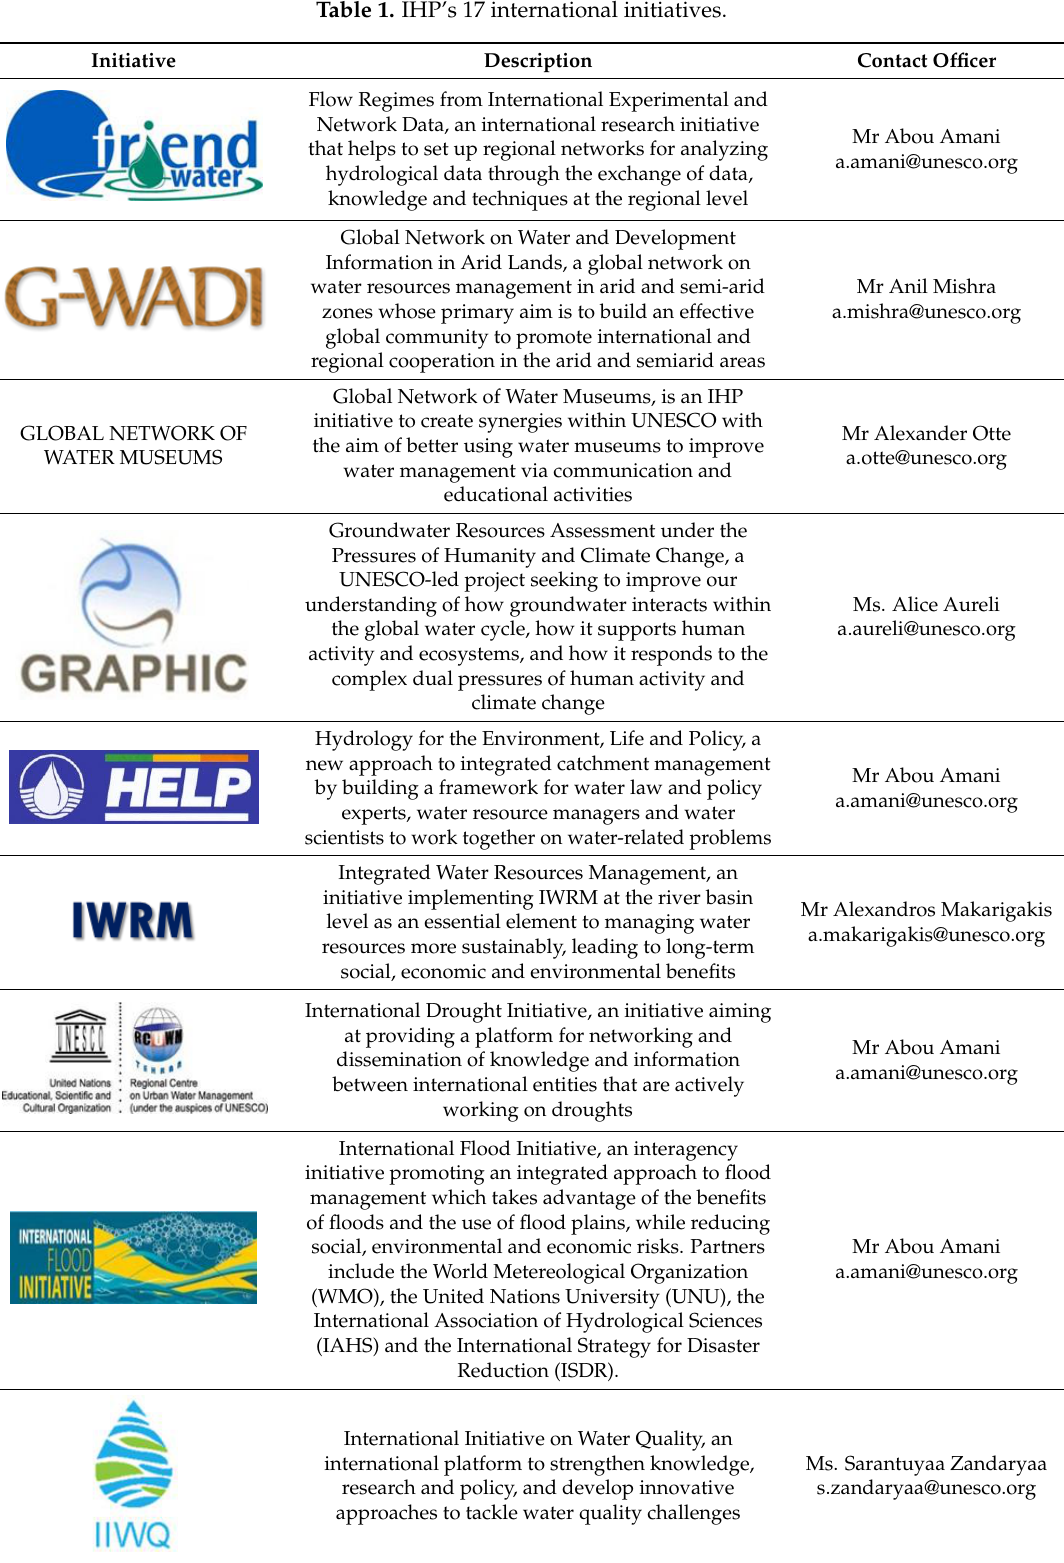
Table 1. IHP’s 17 international initiatives.